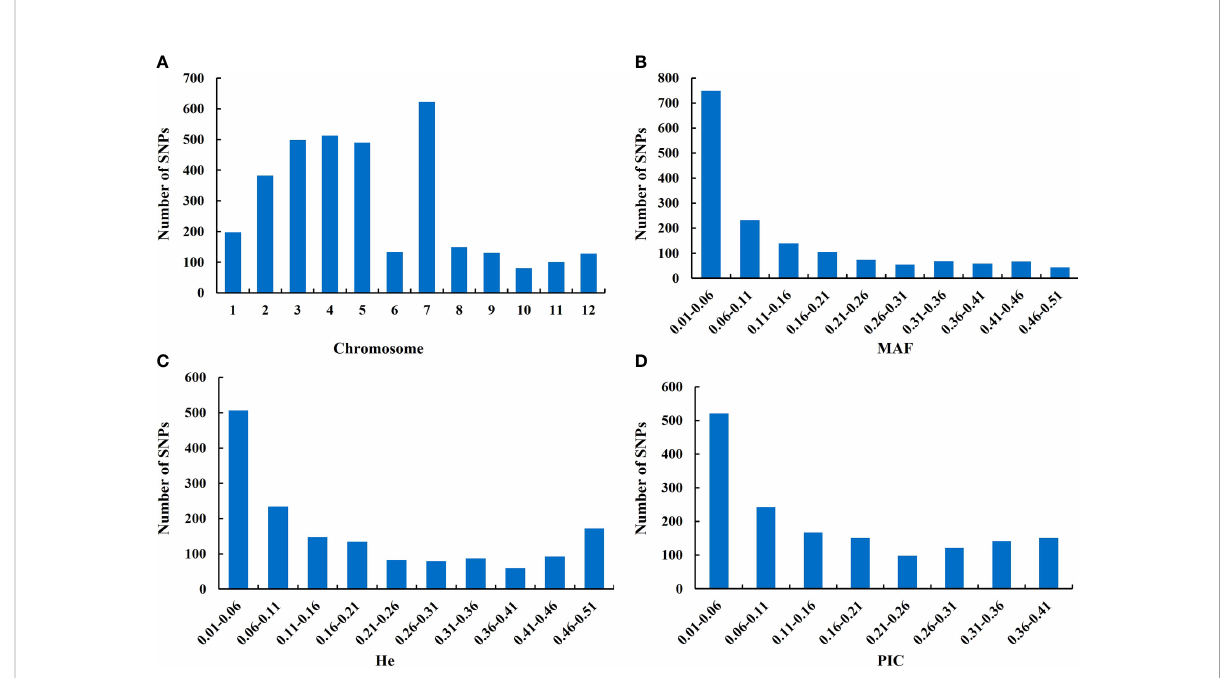
FIGURE 2 Characteristic statistics of SNPs. (A) SNP distribution on the rice scaffolds; (B) minor allele frequency (MAF); (C) expected heterozygosity (He); (D) polymorphism information content (PIC). The Y -axis represents the number of